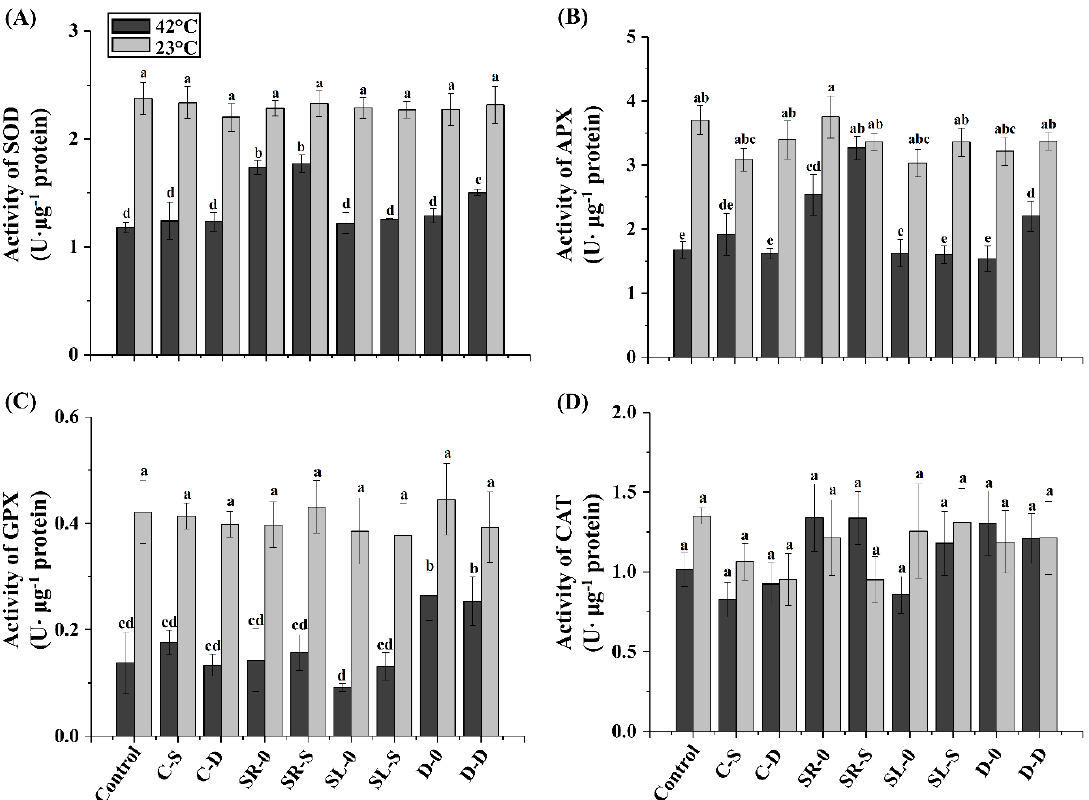
Figure 4. The activities of superoxide dismutase (SOD) ( A ), ascorbate peroxidase (APX) ( B ), guaiacol peroxidase (GPX) ( C ), and catalase (CAT) ( D ) as affected by a high temperature in the different treatments. Lowercase letters indicate significant differences calculated by Duncan’s multiple range test at p ≤ 0.05. Vertical bars indicate the standard error ( n = 3). The letters before the hyphen indicate Si being applied before the cutting propagation, while the letters after the hyphen represent Si being supplied after the cutting propagation. C, control; SR, spraying the runners; SL, spraying the leaves; D, drenching the roots; 0, spraying distilled water; S, spraying the leaves.